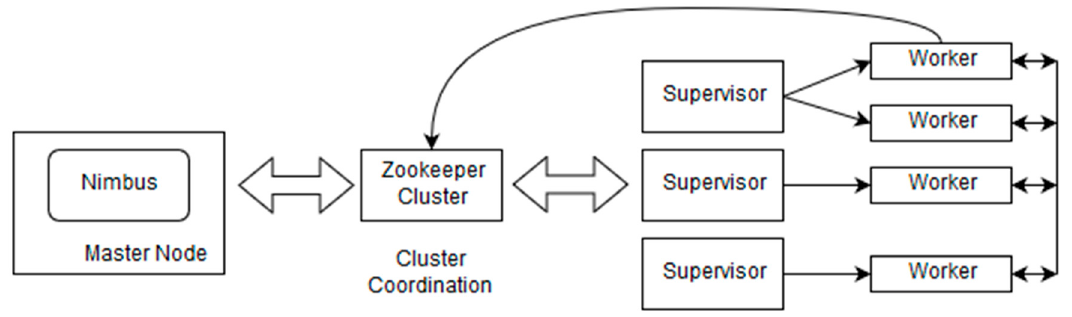
Figure 3. Stream Processing of MOBDA using Storm Architecture.